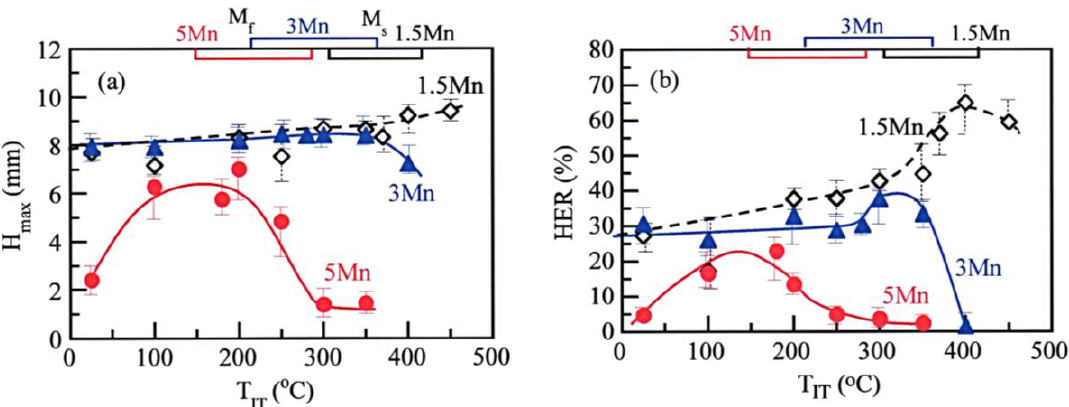
Figure 9. Variations in ( a ) maximum stretch height ( H max ) and ( b ) hole-expansion ratio (HER) as a function of isothermal transformation temperature ( T IT ) in the 1.5Mn ( ◇ ), 3Mn ( ▲ ), and 5Mn ( ● ) steels.